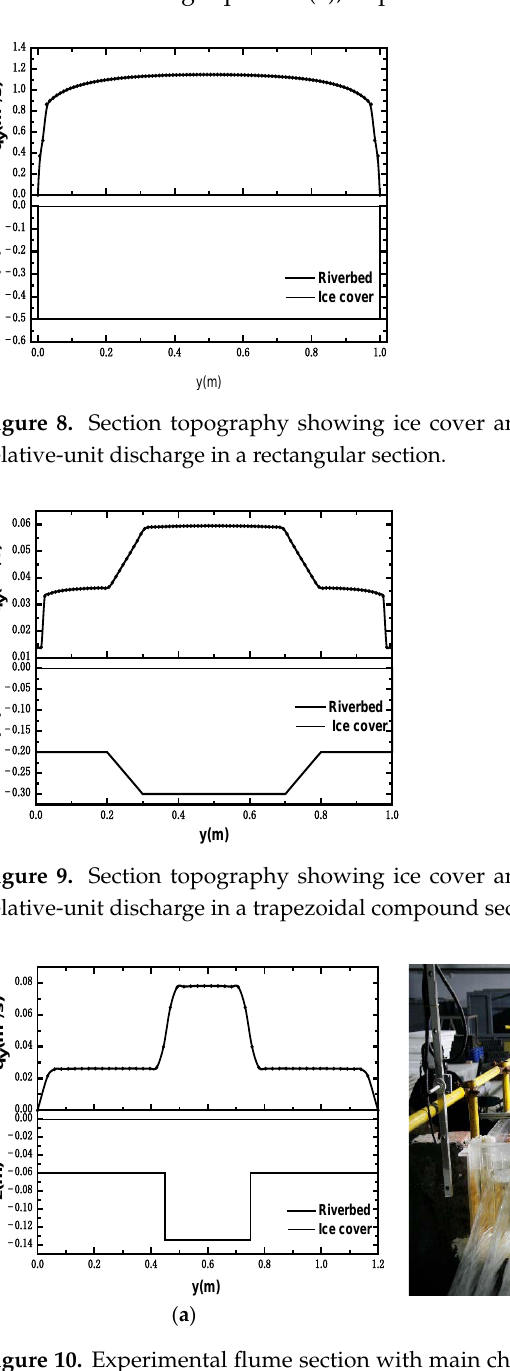
y(m) Figure 11. Section topography showing ice cover and riverbed distribution and cross-sectional rel- ative-unit discharge in a channel section with two thalwegs.